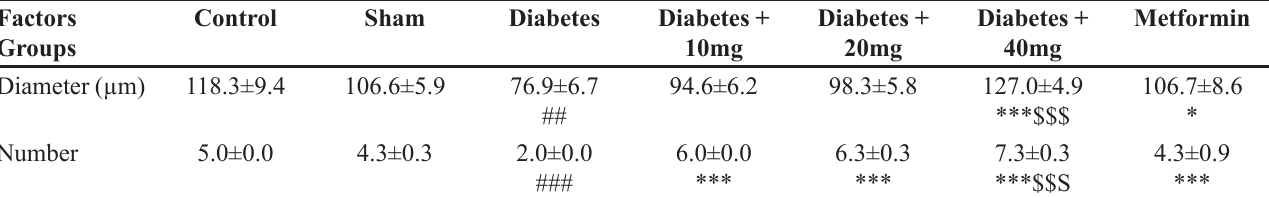
TABLE II - Effect of different doses of betulinic acid on pancreatic islets diameter and number in STZ-NA diabetic mice